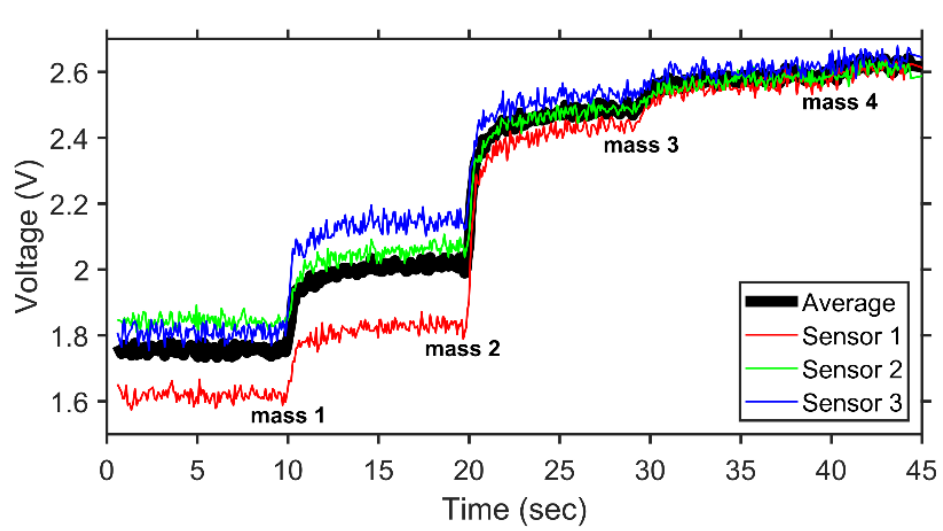
Figure 7. Results of the static testing indicate discrete and distinct levels for each added mass.